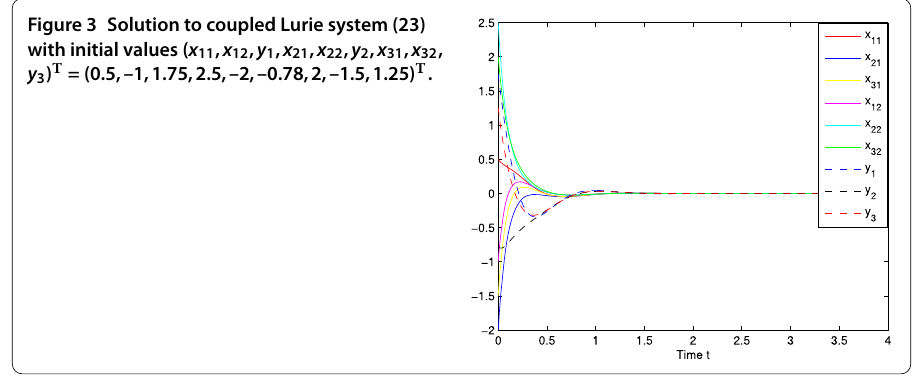
Figure 3 Solution to coupled Lurie system (23) with initial values ( x 11 , x 12 , y 1 , x 21 , x 22 , y 2 , x 31 , x 32